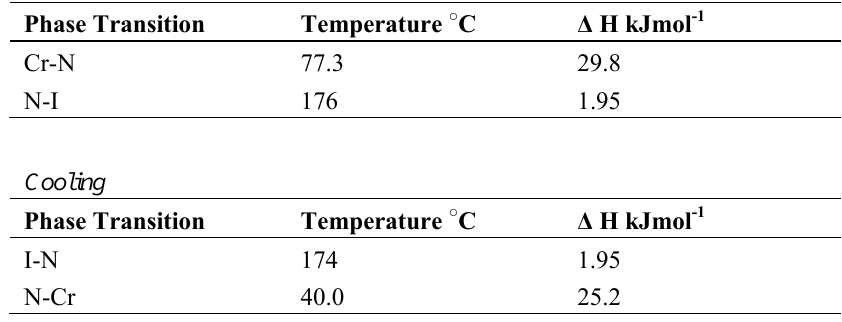
Table 1. Phase transition temperatures and enthalpy changes of compound 4.